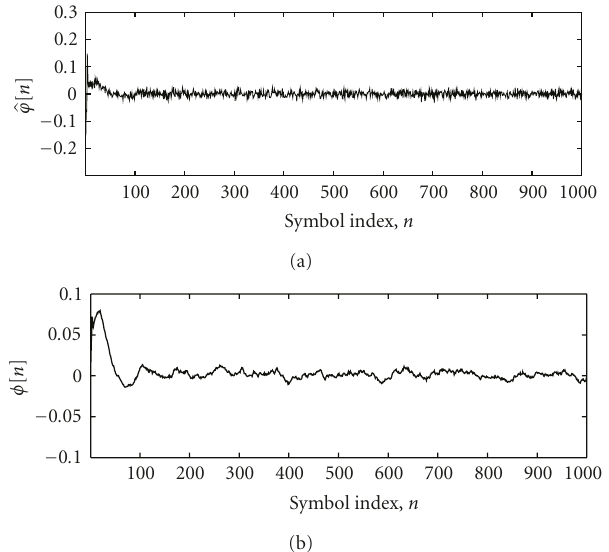
Figure 11: Performance of the PLL for carrier tracking in an SMT receiver. The top figure shows the phase error, ϕ [ n ], at the loop filter input. The lower figure shows the phase jitter, φ [ n ], of the input signal to the analysis filter bank. Note that the vertical scales in two plots are di ff erent.